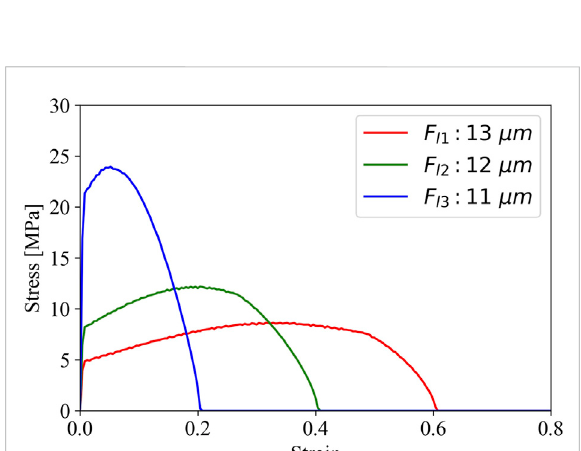
FIGURE 6 The role of the length of fi bers in modifying the stress-strain behavior of a fi brous microstructure. The longer the fi bers, the greater is the ability of the microstructure to accommodate strain (red curve) with the respect to microstructures characterized by shorter fi bers (blue